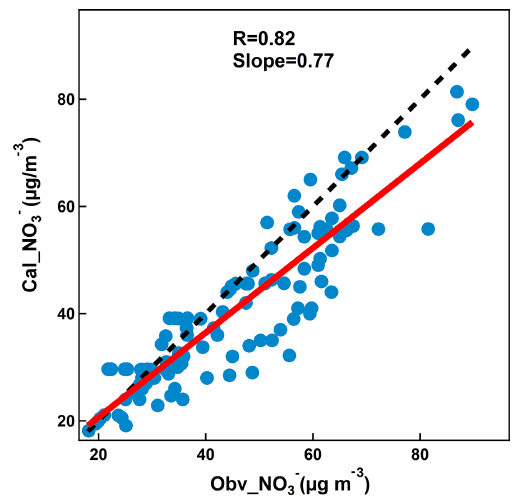
Figure 10. Scatter plot of calculated nitrate concentrations and ob- served nitrate concentrations from 17:00 to 23:00 of each